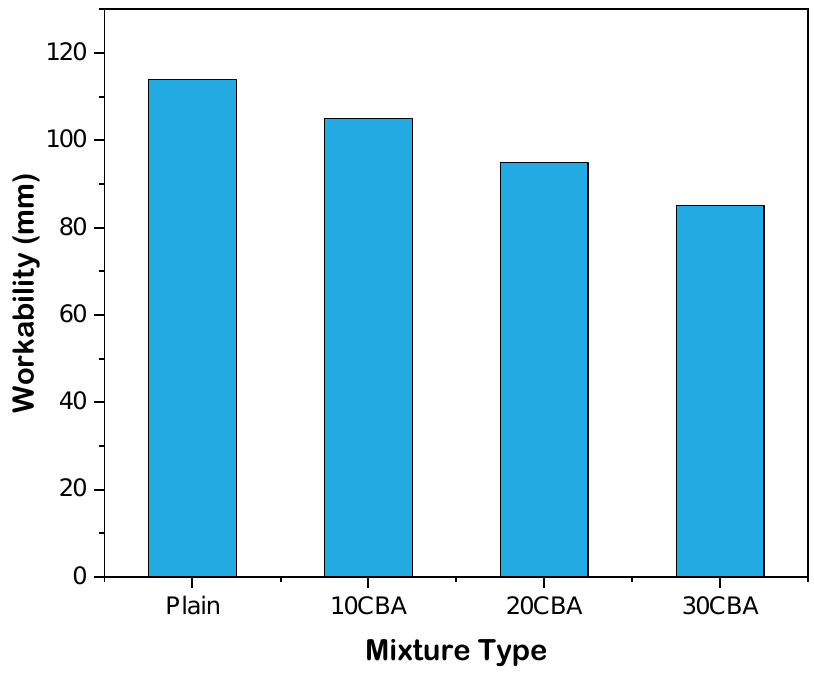
Figure 2. Workability of the mixture blended with